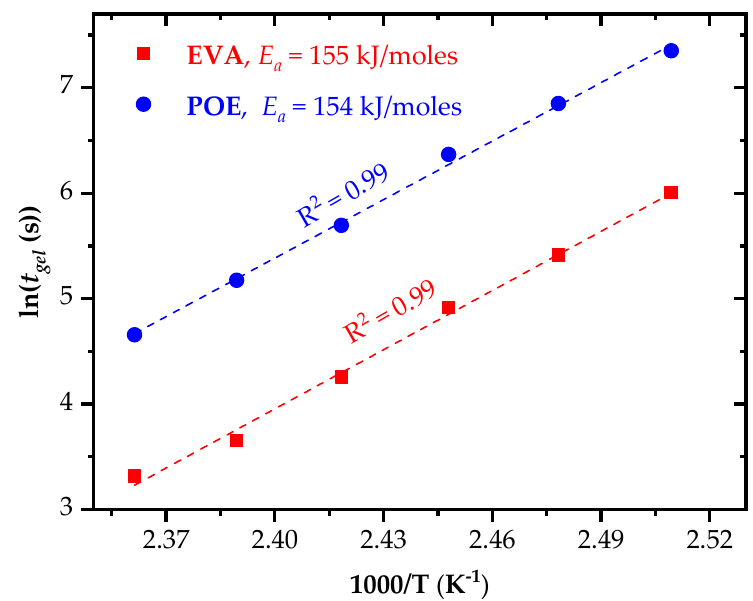
Figure 4. Arrhenius plots and activation energy for EVA and POE encapsulants.